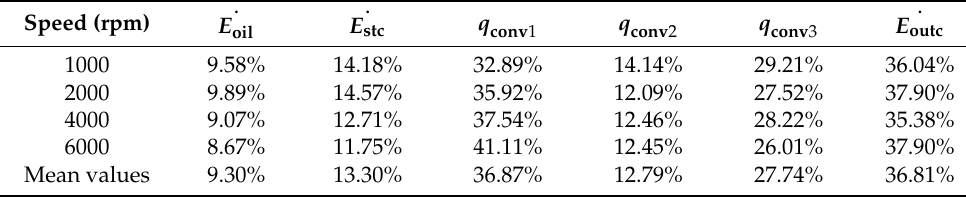
Table 5. Heat loss distribution proportion at different